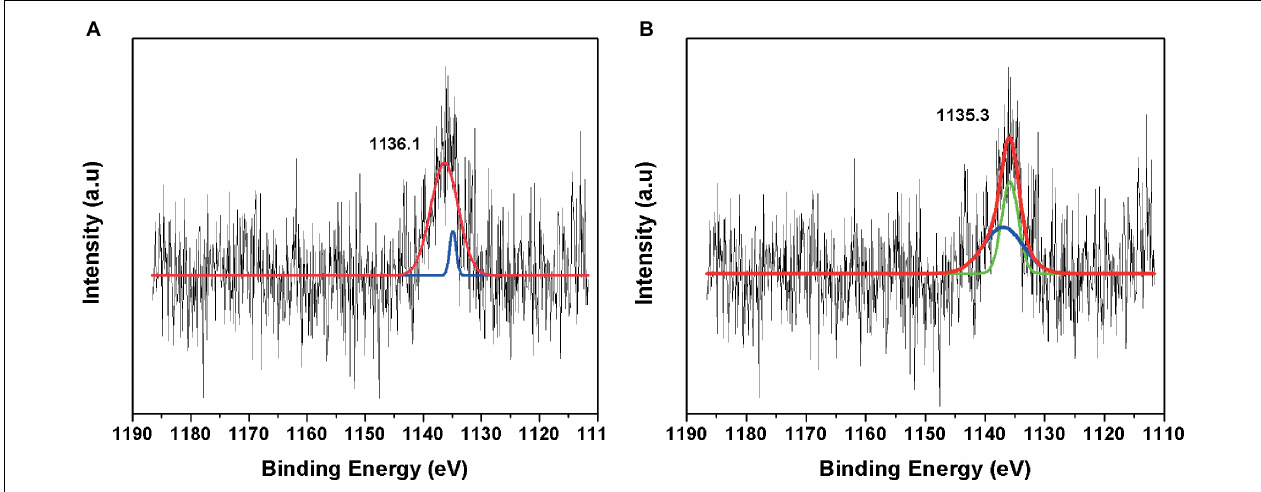
FIGURE 6 | High-resolution XPS spectrum of (A) negative control amended with Eu and (B) minerals formed in TYG media amended with Eu and T. scotoductus SA-01.